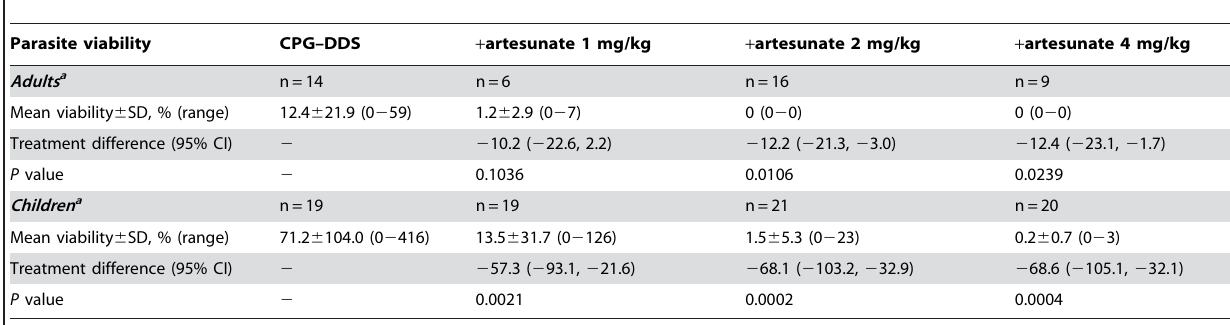
Table 3. Ex-vivo parasite viability at 12 h after the first dose of study drug in the Day 3 per-protocol population.